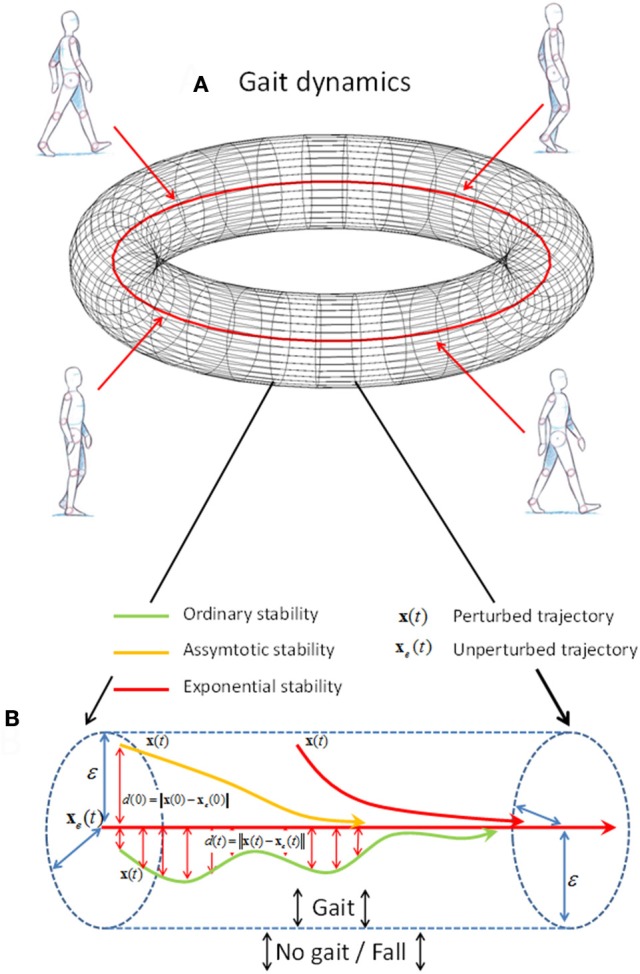
A schematic representation of the construct of stability of motion. (A) The unperturbed gait dynamics xe(t) is represented as a red orbit with a ε radius torus around. The ε-boundary represents a small distance for which the perturbed gait dynamics x(t) for a small perturbation of size d(0) < δ remain within. (B) A schematic representation of ordinary stability (green line), asymptotic stability (yellow line), and exponential stability (red line) within a section of the torus (blue dashed lines). The distance d(t) between the unperturbed xe(t) and the perturbed gait dynamics x(t) has to be within the ε < radius for the dynamics to be stable. In addition, the yellow arrow has to approach the unperturbed trajectory xe(t) (red center line) as t → ∞ when the gait dynamics is asymptotic stable. Moreover, the red arrow has to approach the red arrow exponential fast where d(t) ≤ d(0)exp(λt) and the Lyapunov exponent λ < 0, when the dynamics is exponentially stable.